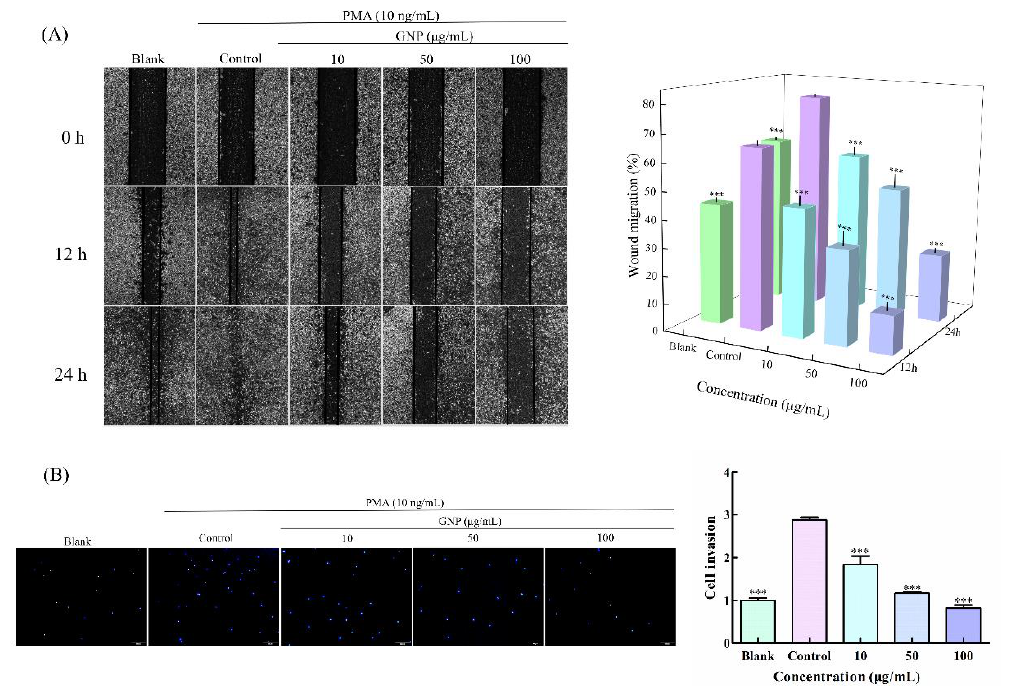
Figure 2. ( A ) The influence of GNP on HT1080 migration. Scraping the confluent cell monolayer to create the wounds, and the migration was observed at 0, 12 and 24 h, respectively. ( B ) The effect of GNP on HT1080 cells invasion. Data are shown as mean ± SD ( n = 3), p < 0.001 (***) compared with PMA alone treated control group.